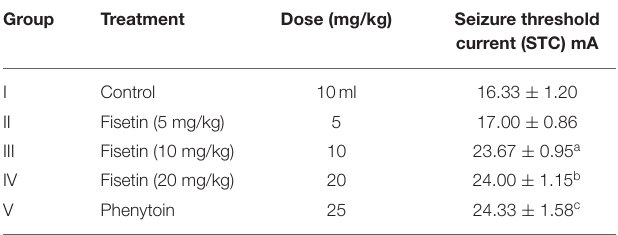
TABLE 1 | Effect of fisetin administration on seizure threshold current on ICES test in experimental mice. Group Treatment